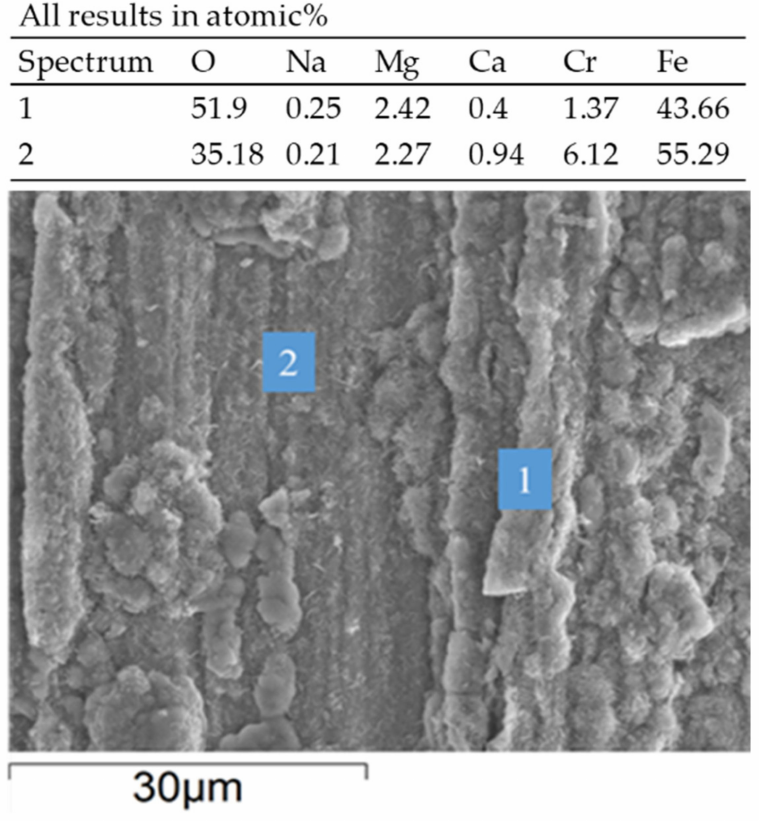
Figure 9. SEM-EDX measurements on the VM12 surface underneath the “Solar Salt” in accelerated flow conditions (0.2 m/s) at 500 ◦ C after 2000 h